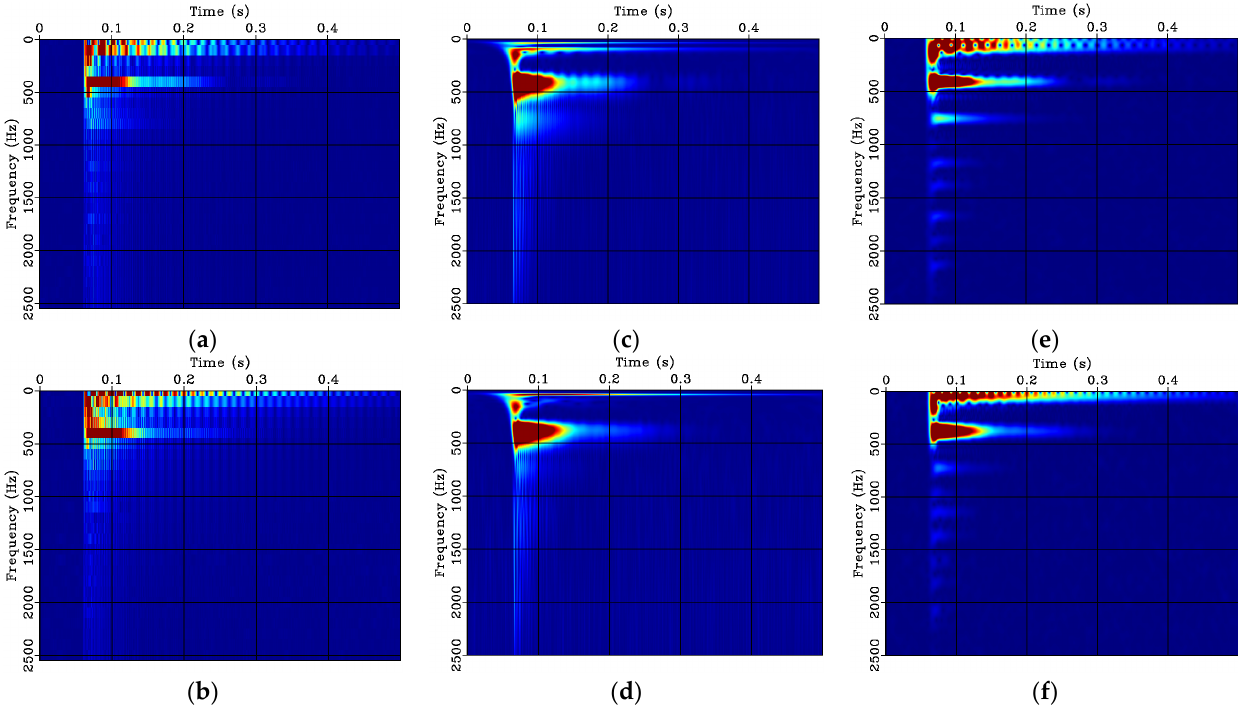
Figure 15. Time-frequency spectra of un8-8 and cr8-8: ( a ) STFT of un8-8; ( b ) STFT of cr8-8; ( c ) ST of un8-8; ( d ) ST of cr8-8; ( e ) LTFT of un8-8; ( f ) LTFT of cr8-8.